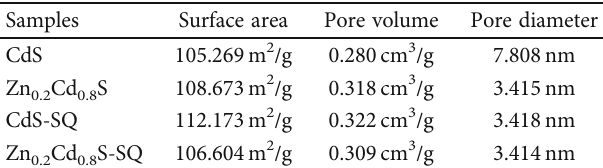
Figure 1: (a) and (b) Di ff ractograms of CdS and CdS-SQ by coprecipitation and sonochemistry. (b) and (d) Di ff ractograms of